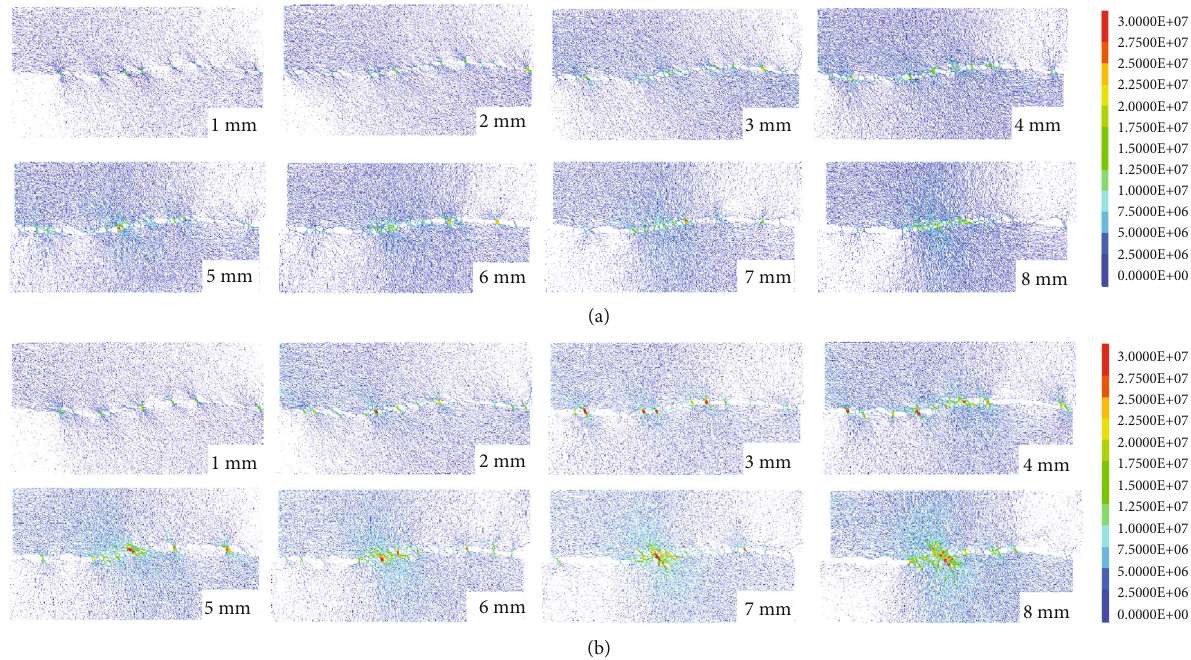
Figure 8: Evolution of contact force between particles during shearing: (a) low-strength rock joints; (b) high-strength rock joints.